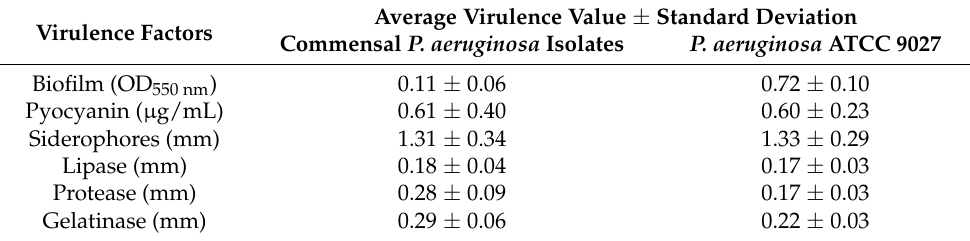
Table 3. Production of biofilm, pyocyanin, siderophores, lipase, protease, and gelatinase in commen- sal P. aeruginosa isolates and P. aeruginosa ATCC